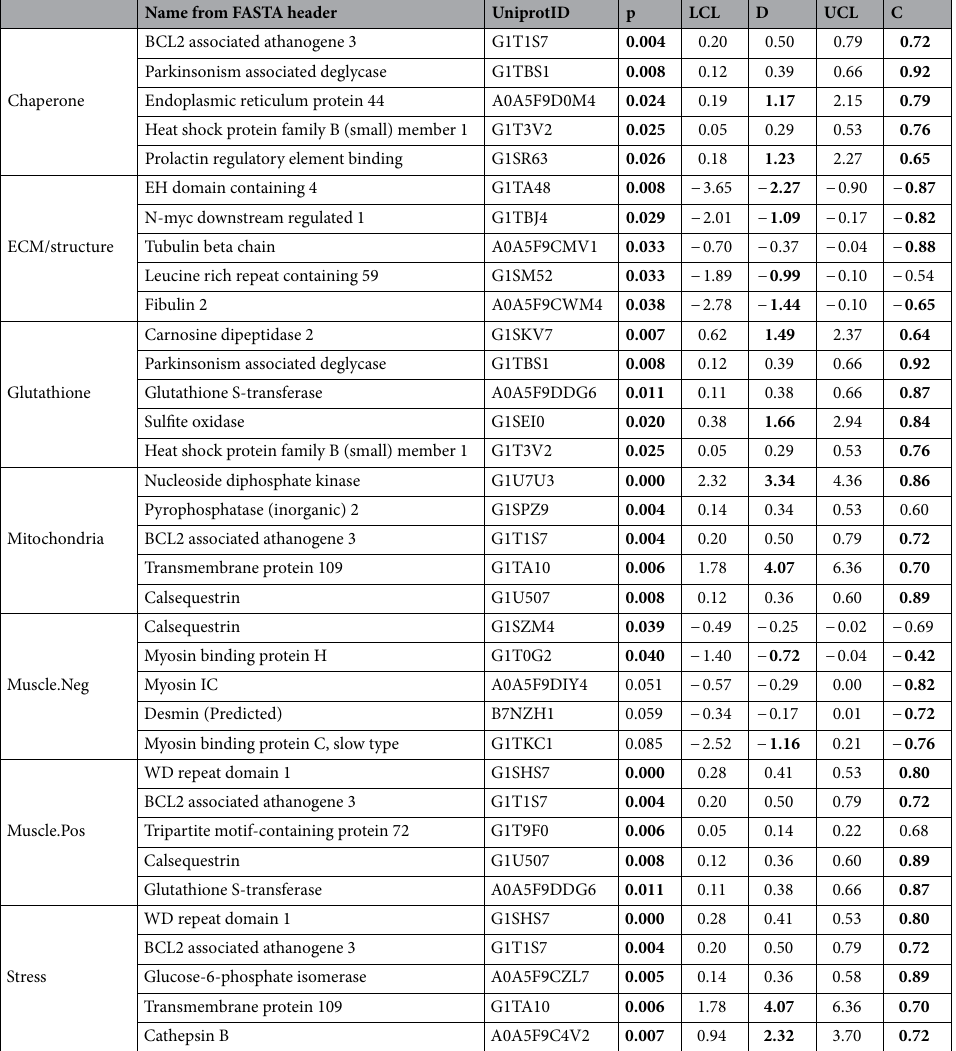
subsets tested. The UniProt ID displayed is the first of multiple when multiple mappings were provided. Name is a non-unique identifier obtained from the FASTA header for the protein. Uncorrected p-values (p)